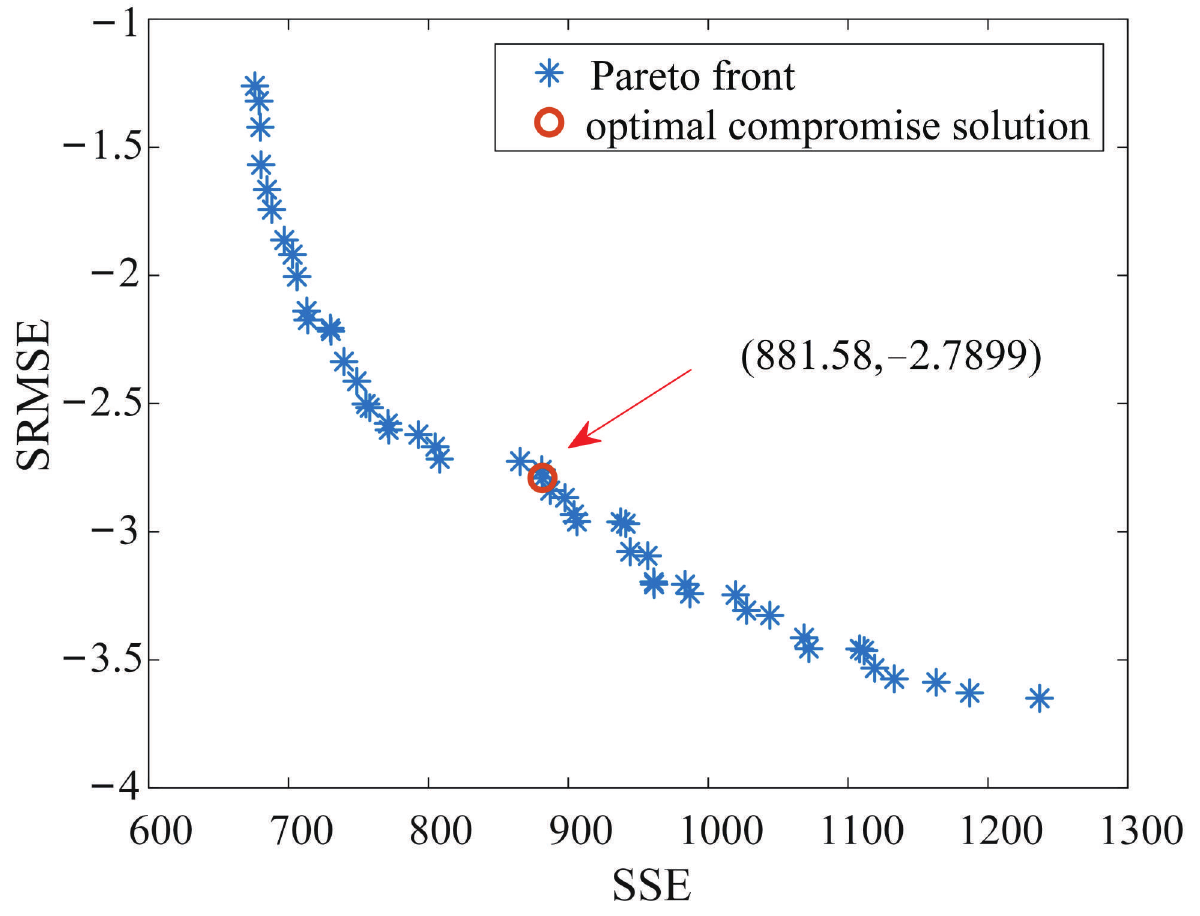
Figure 6. Pareto front of season 1 of proposed multi-objective clustering model solved by